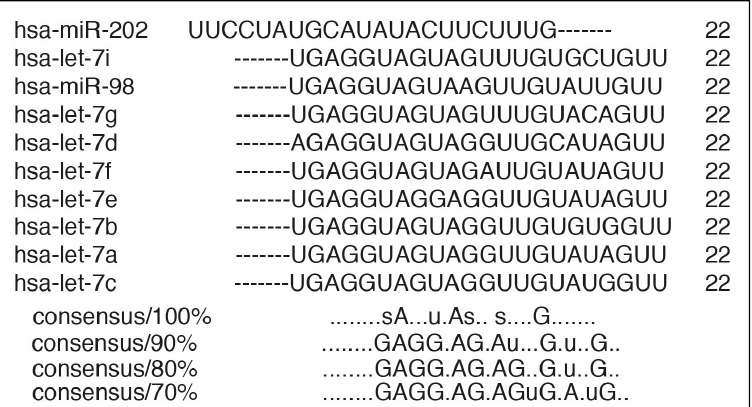
Figure 1. Sequence alignment of the let-7 microRNAs. Performed with ClustalW tool (https://www.genome.jp/tools-bin/clustalw (accessed on 2 April 2021).